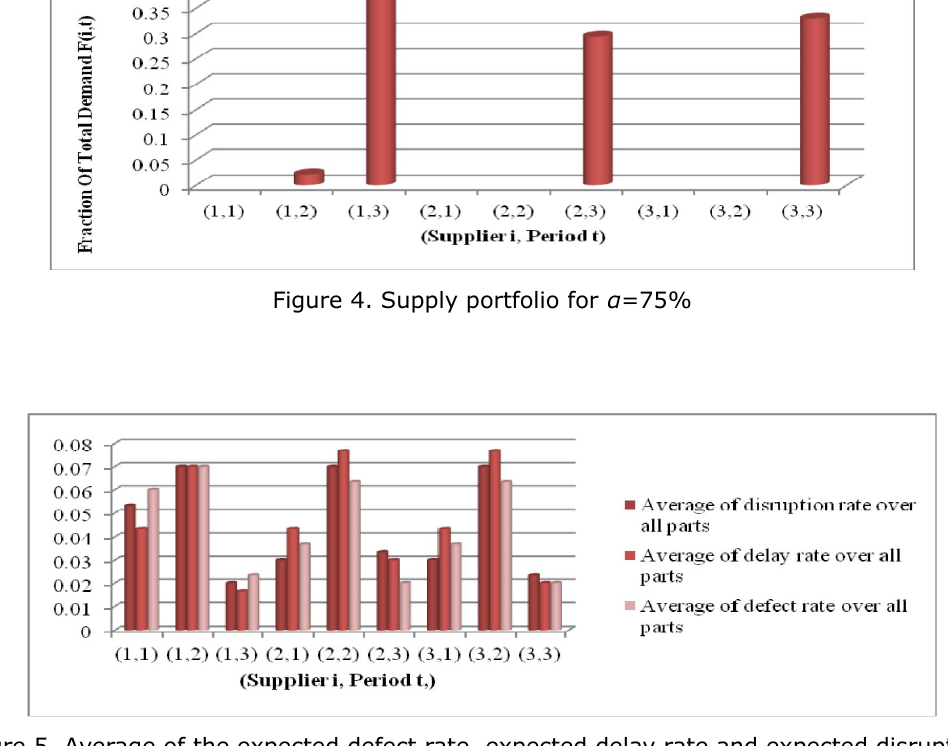
Figure 5. Average of the expected defect rate, expected delay rate and expected disruptions rate for all part types for each period and each